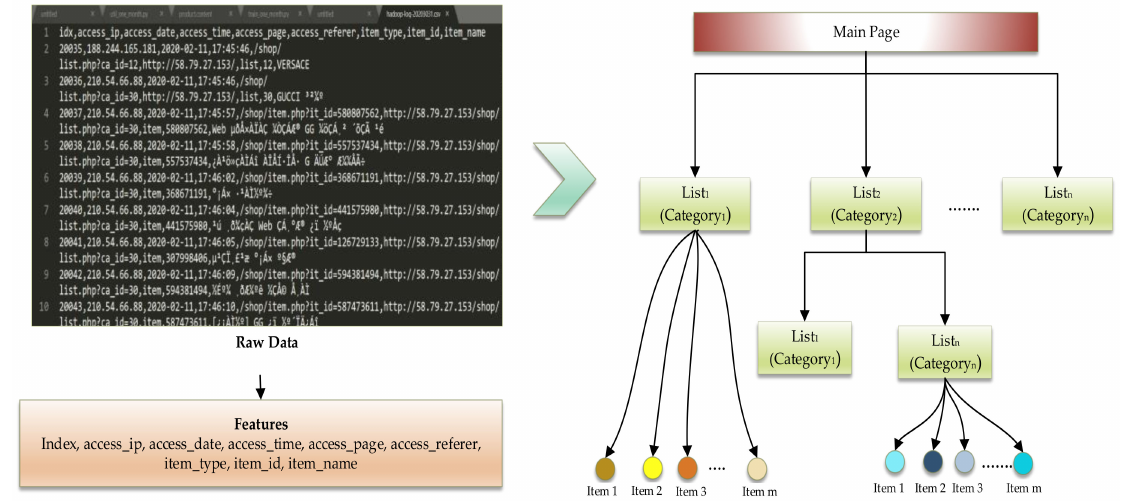
Figure 5. Data categorization from raw data.